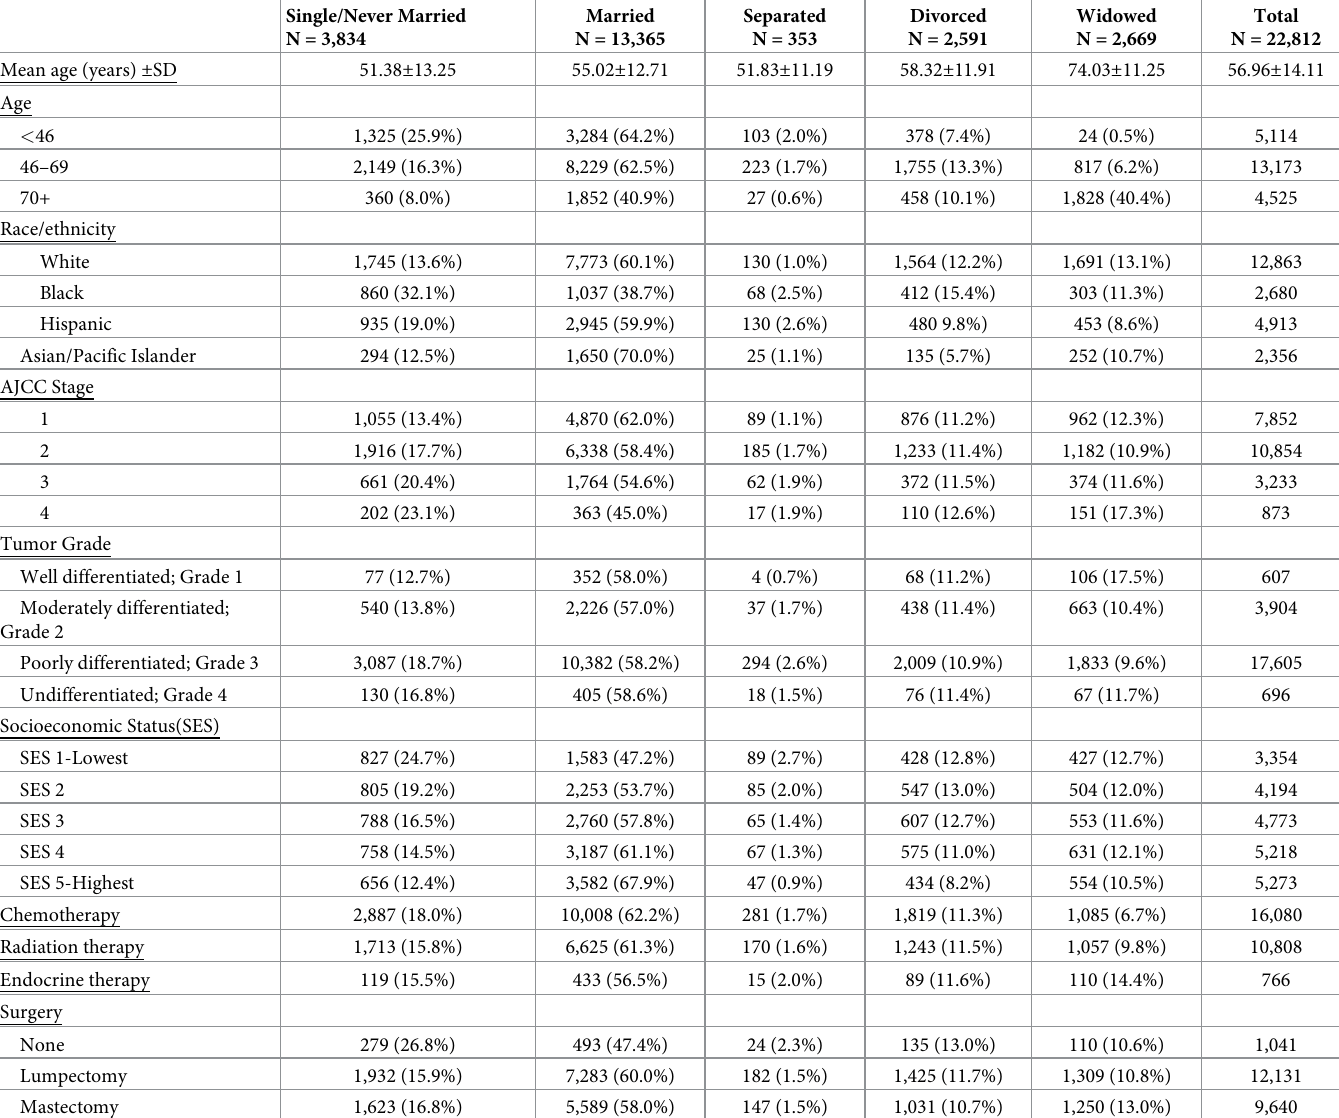
Table 1. Demographic and clinicopathologic characteristics of 22,812 cases of triple negative first primary female breast cancer from the California Cancer Registry